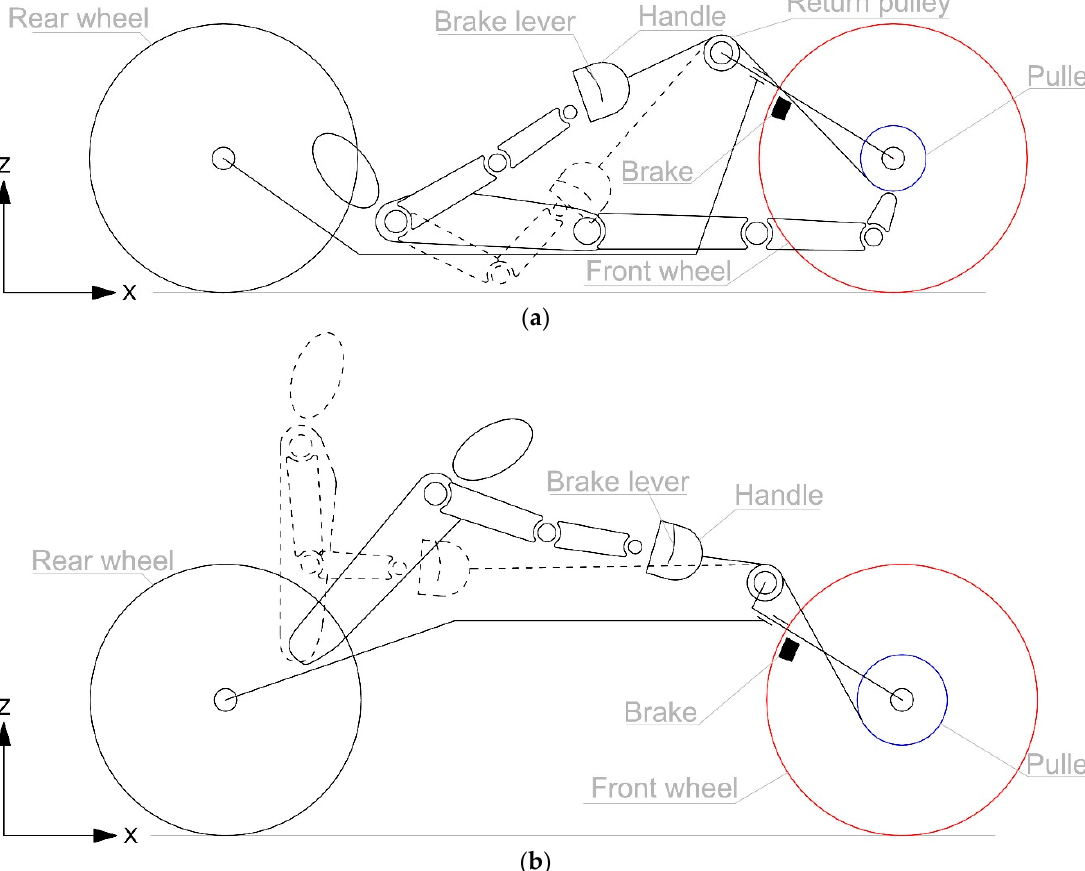
Figure 5. ( a ) Innovative system applied to the recumbent Handbike; ( b ) Innovative system applied to Figure 15 the